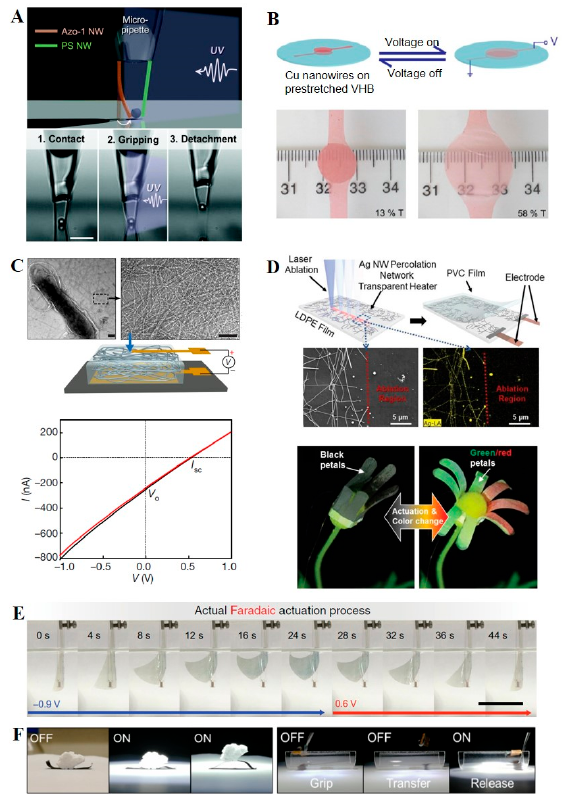
Figure 1. ( A ) Photomechanical nanowire tweezer composed of an azobenzene nanowire and polystyrene (PS) nanowire. Reproduced with permission [29]. Adapted with permission under